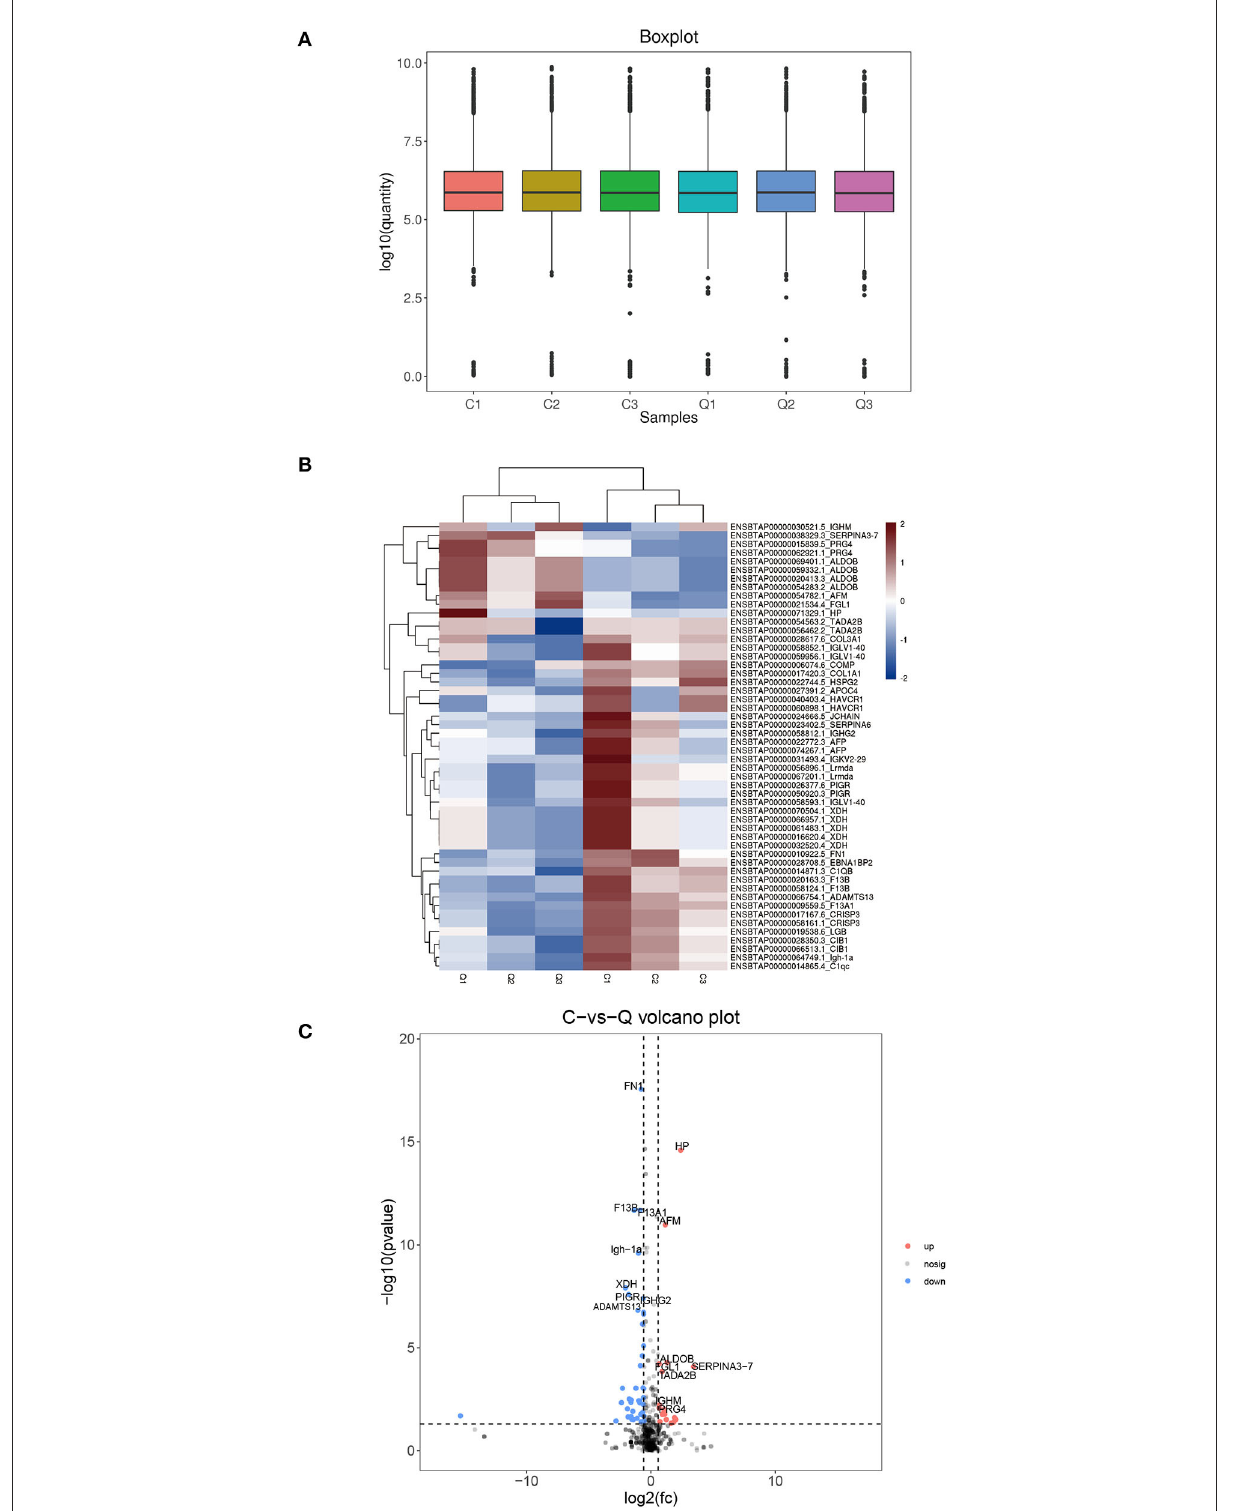
FIGURE1 The differential plasma proteins in DHD calves and clinically healthy calves. C indicates clinically healthy calves and Q indicates DHD calves. (A) Normalized box diagram. The distribution of the normalized quantitative value of the peptide showed that the signal intensity of each group was basically the same. (B) Heatmap of the differentially expressed proteins. Plasma samples represent in the columns, and the differentially expressed proteins are delineated in rows. The color of each cell shows that red represents upregulation and blue represents downregulation. (C) Volcano plot of proteins with the most significantly different abundance levels in plasma samples of calves with DHD. Increased protein levels are presented on the positive X-axis and decreased levels are presented on the negative